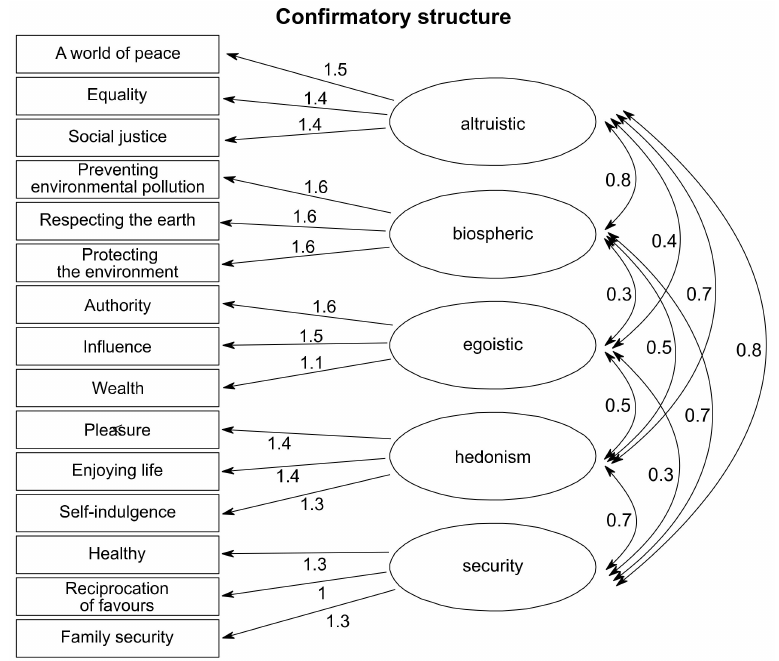
Figure 2. Factor loadings for value items and correlations between latent factors from confirmatory factor